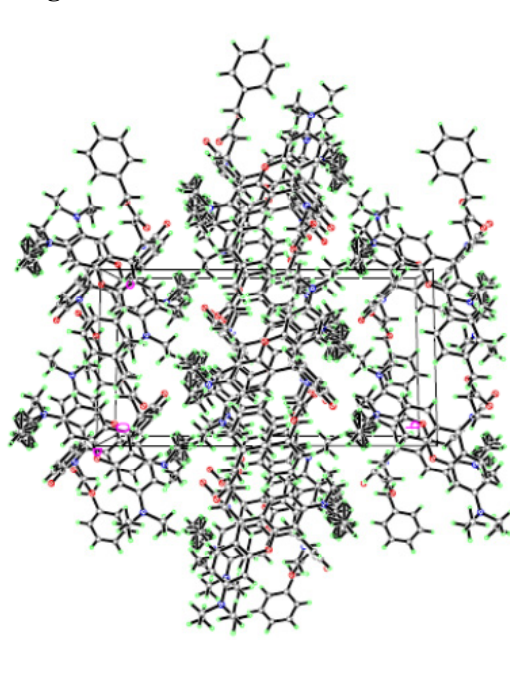
Figure 3. Network structure of RBAP